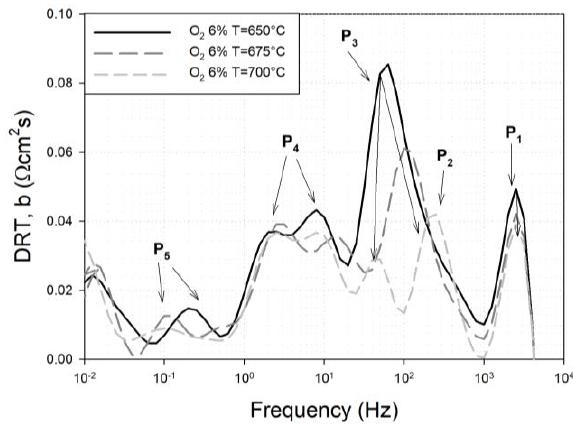
Figure A1. Effect of temperature variation on the DRT spectra.